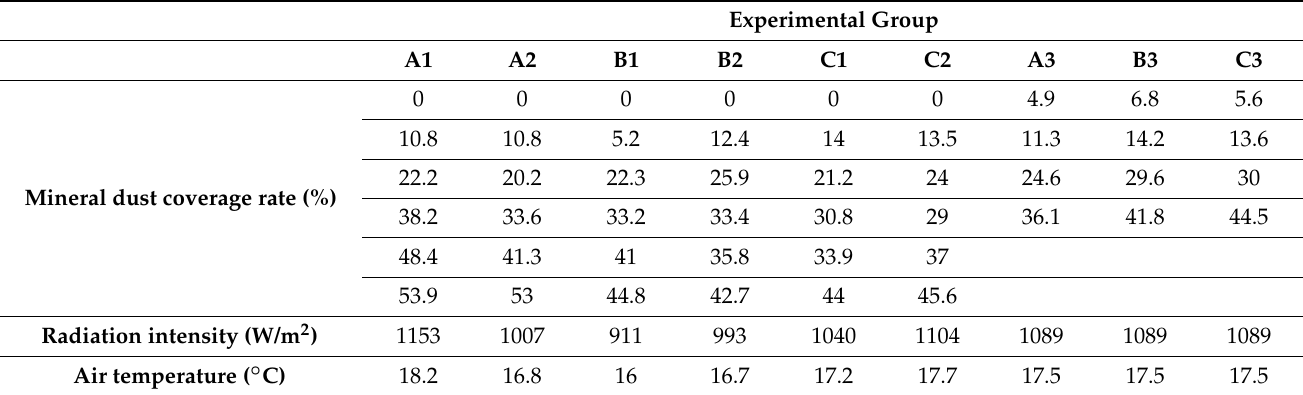
Table 2. Ice surface mineral dust coverage rate, radiation intensity, and air